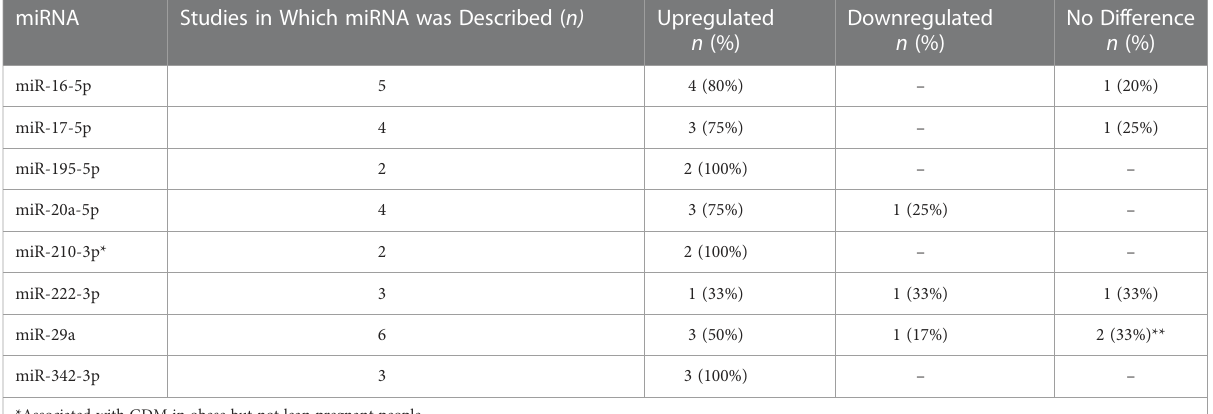
TABLE 4 miRNAs described in two or more studies. miRNA Studies in Which miRNA was Described ( n)